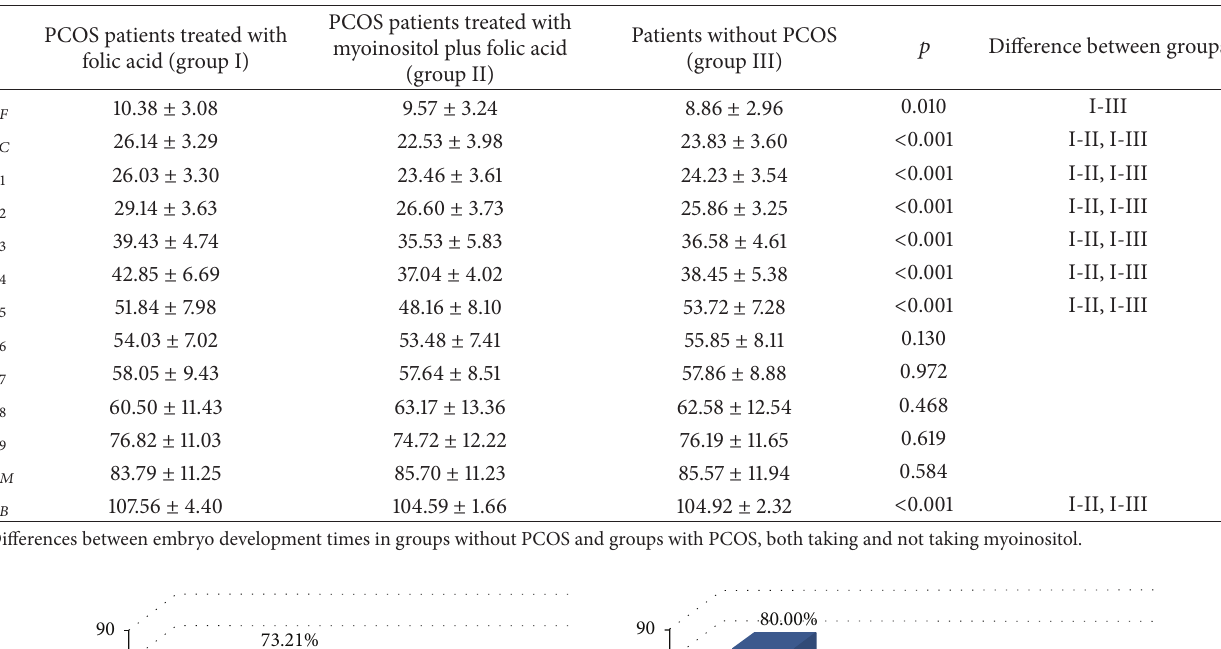
Table 1: Embryo development times.